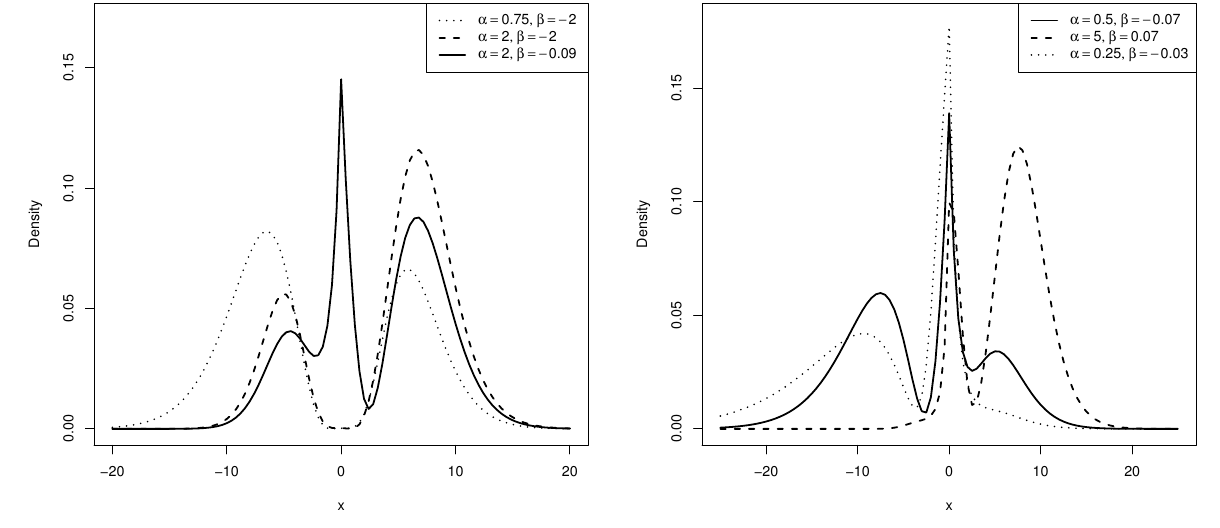
Figure 4. Probability density function of EBSL (𝛼,𝛽)(𝛼,𝛽)(𝛼,𝛽) for selected values of 𝛼𝛼𝛼 and 𝛽𝛽𝛽